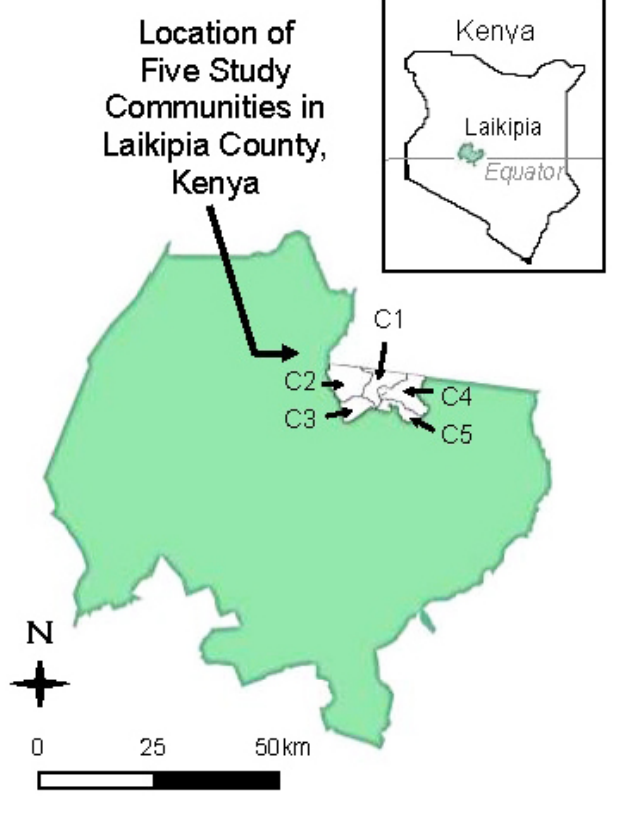
Fig. 1 . Location of study communities in Laikipia County,